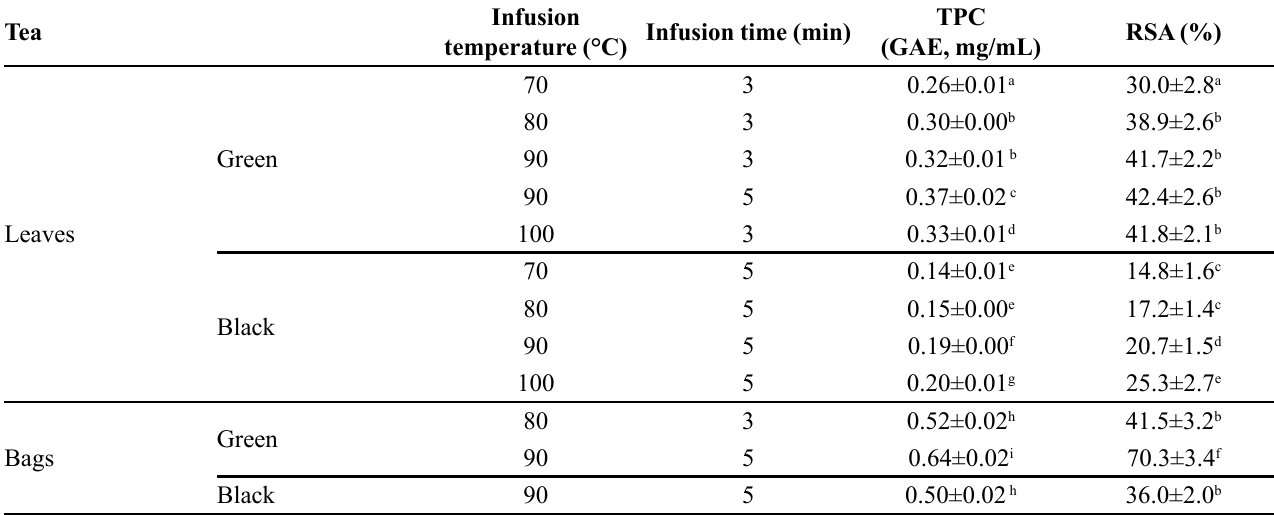
TABLE I - Effect of the infusion temperature and time on the total phenolic content (TPC) and radical scavenging activity (RSA) of green and black teas